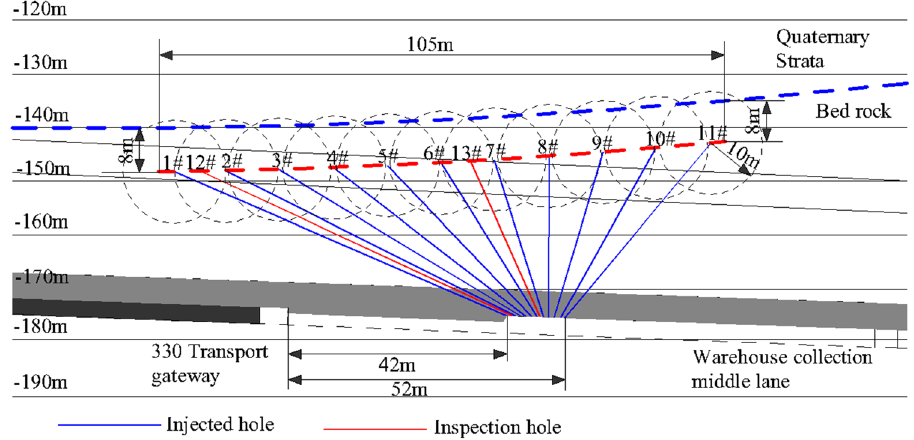
Figure 10. Plan of drilling holes for grouting reinforcement of Quince Tree No. 2 Fault.